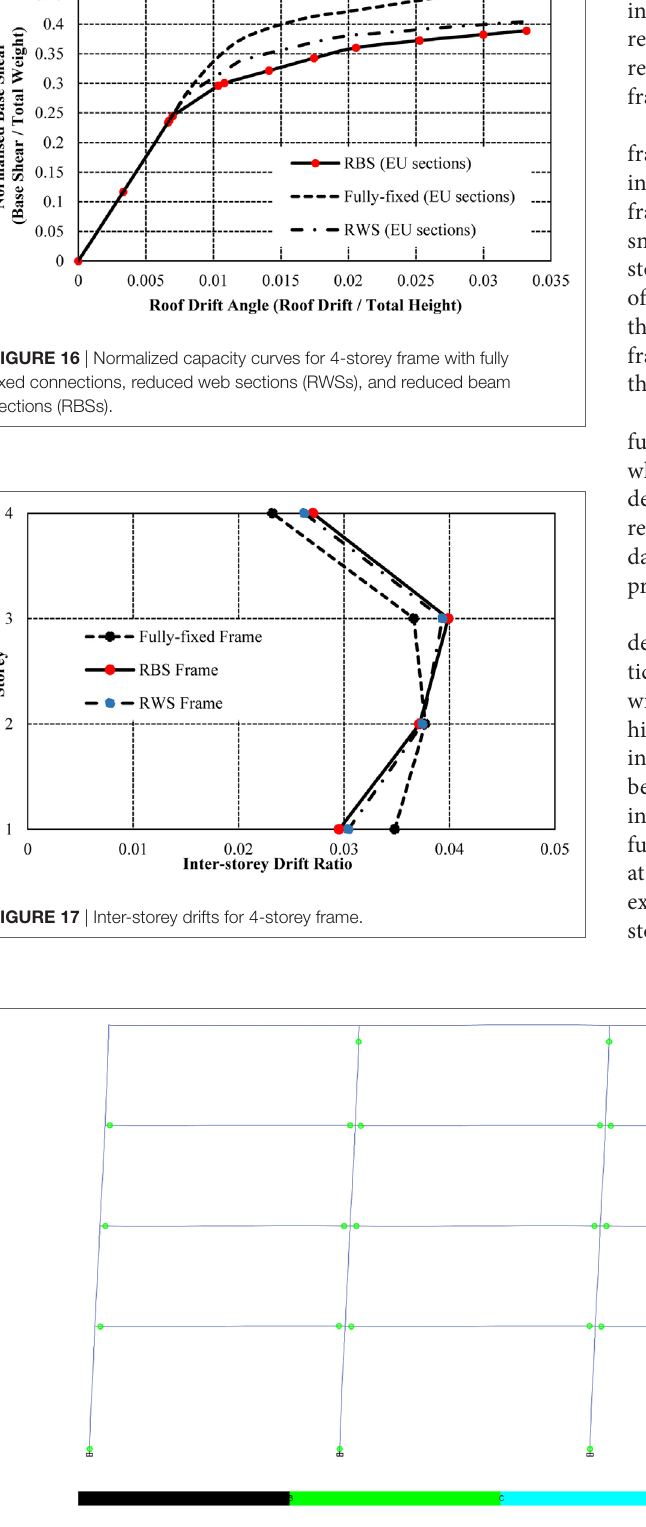
Figure 18 | Plastic hinge formation in fully fixed 4-storey frame (for cross sections, see Figure 5 and Table 2